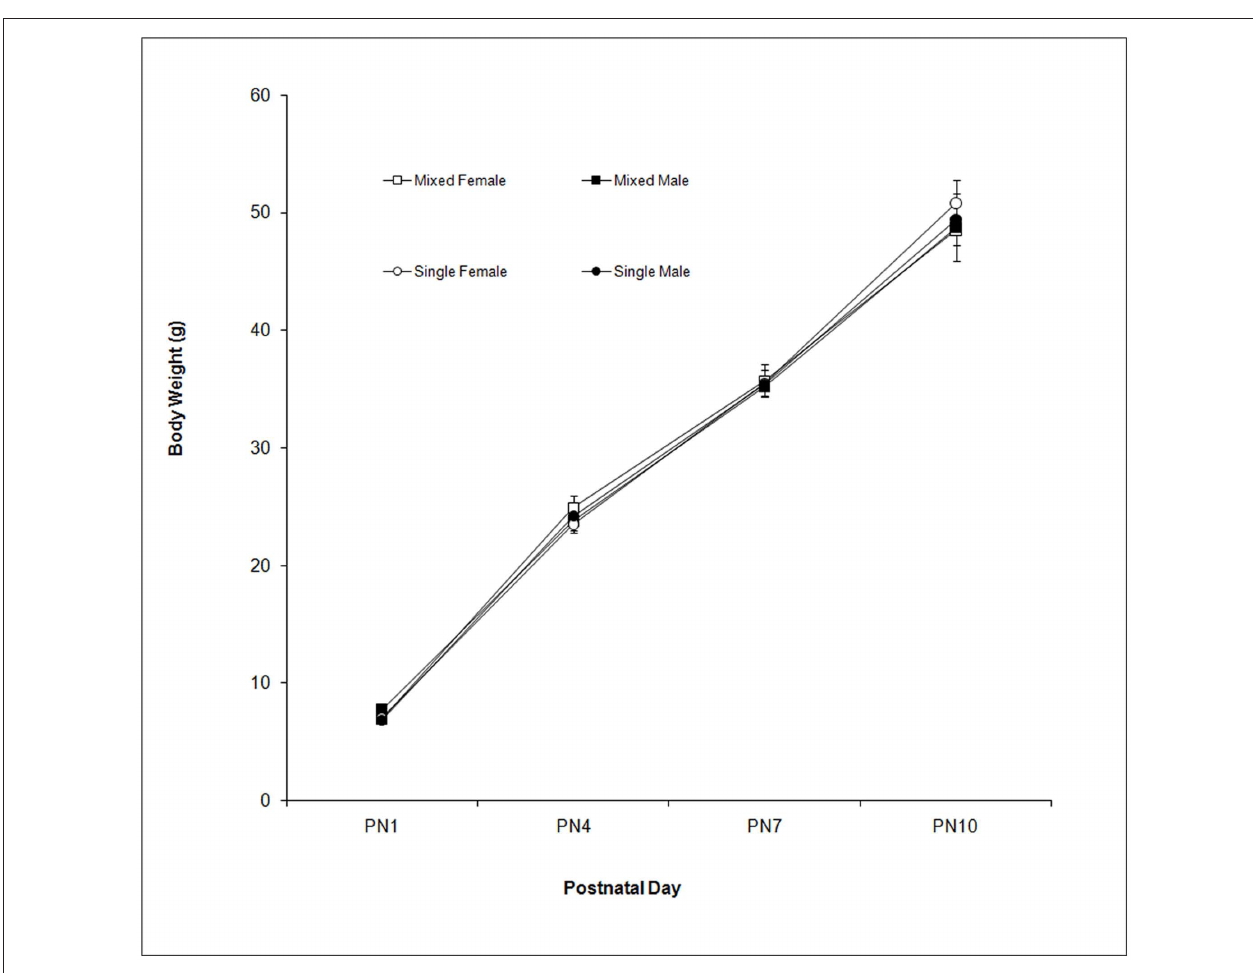
FiguRE 1 | Mean ( ± SEM) body weight (g) is presented for mixed- (squares) and single- (circles) sex litters for female (open symbols) and male (closed symbols) rats over postnatal days. All groups gained weight over this period with no effect of LGC or Sex seen.